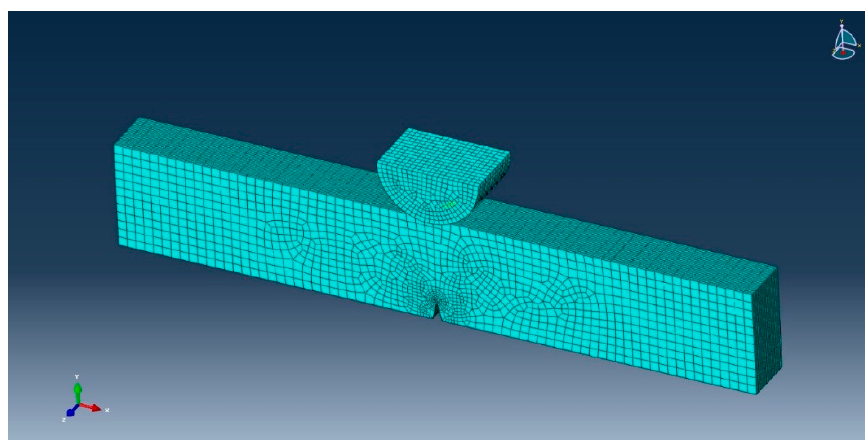
Figure 7. Meshed specimen.